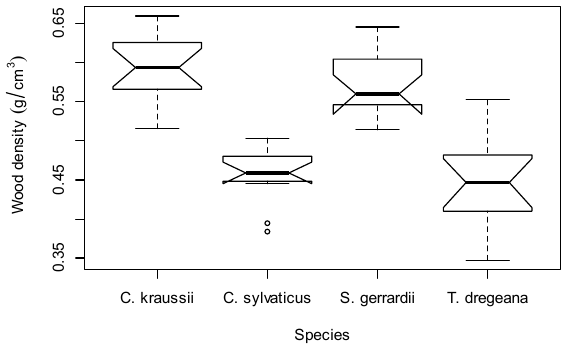
Figure 1. Variation of wood density (g/cm 3 ) among study species.